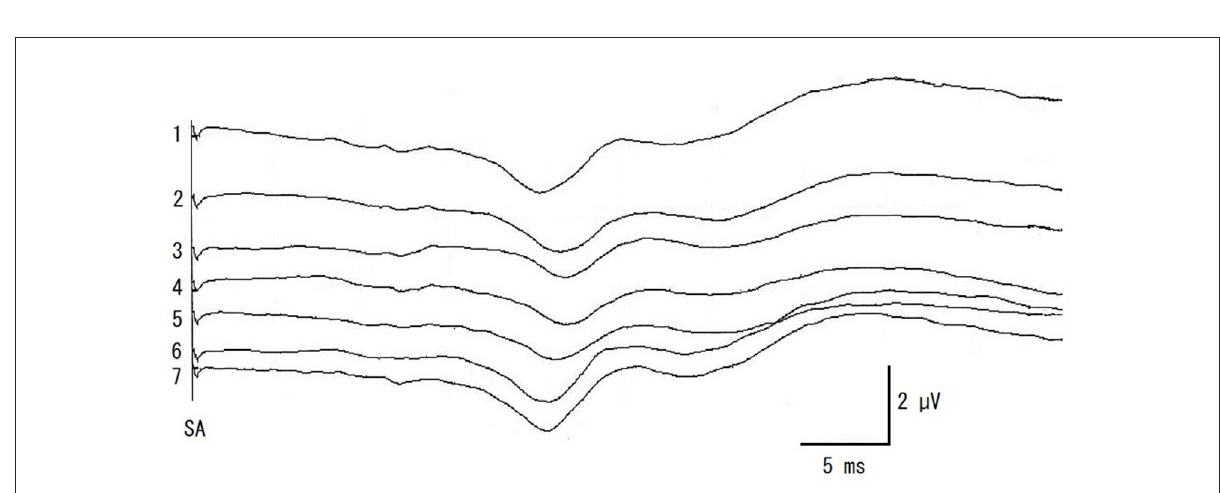
FIGURE3 The recordings of intraoperative SEP monitoring in a case of Figure 2. 1: pre-operative control, 2: retracting multifidus muscles, 3: halting surgical procedure and multifidus muscles loosened, 4: hemilaminectomy, 5: removing the disk materials from the spinal canal, 6: closing multifidus muscles, 7: end of the surgery. SA, electrical stimulation